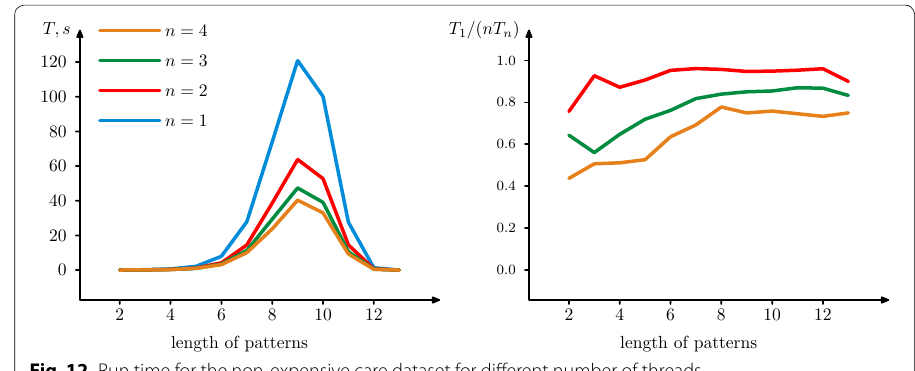
Fig. 12 Run time for the non-expensive care dataset for different number of